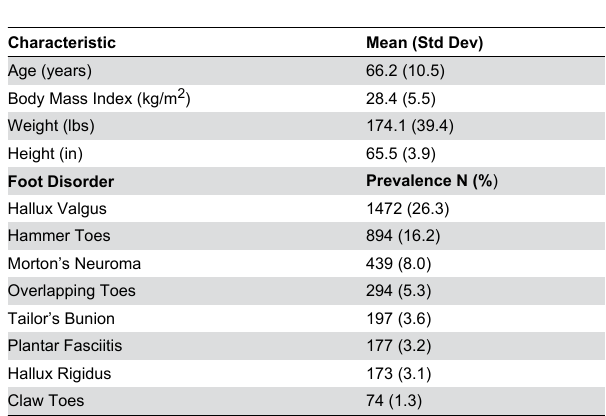
Table 1. Participant characteristics and prevalence data